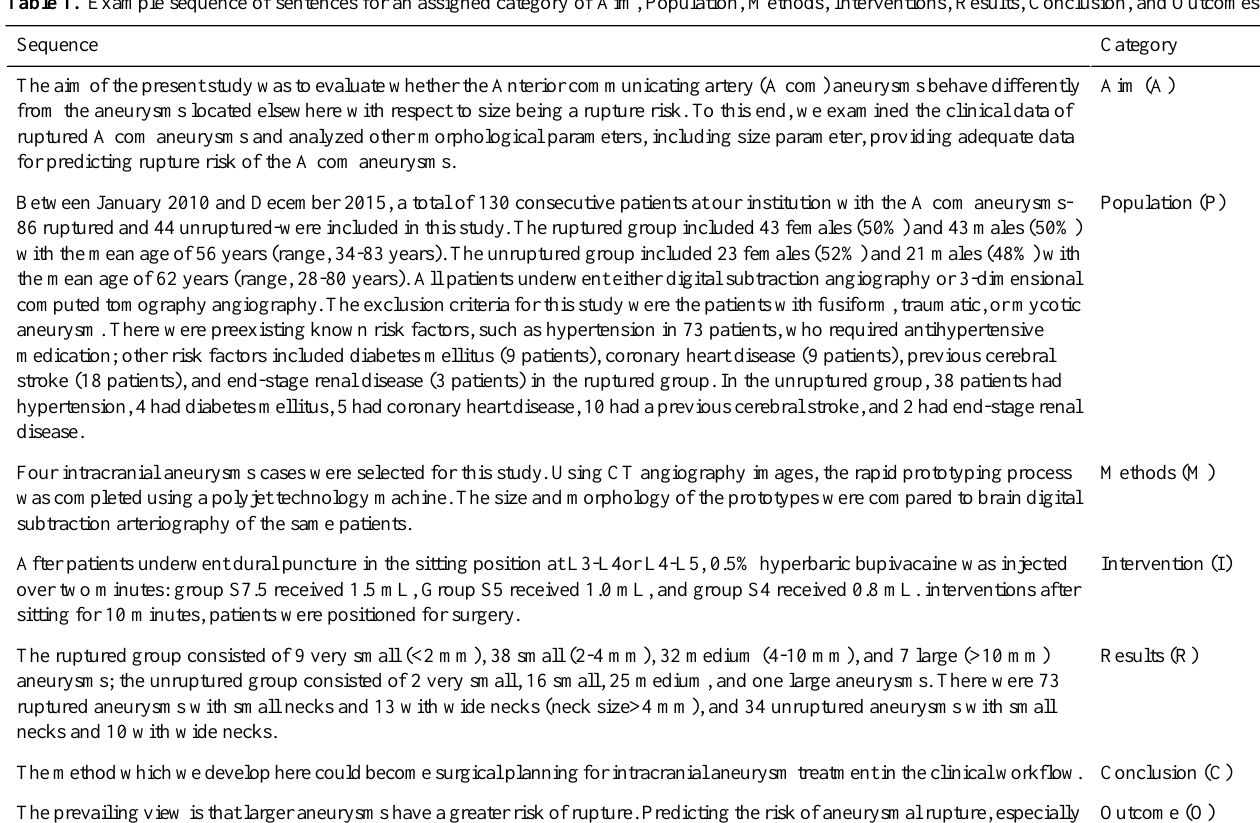
Table 1. Example sequence of sentences for an assigned category of Aim, Population, Methods, Interventions, Results, Conclusion, and